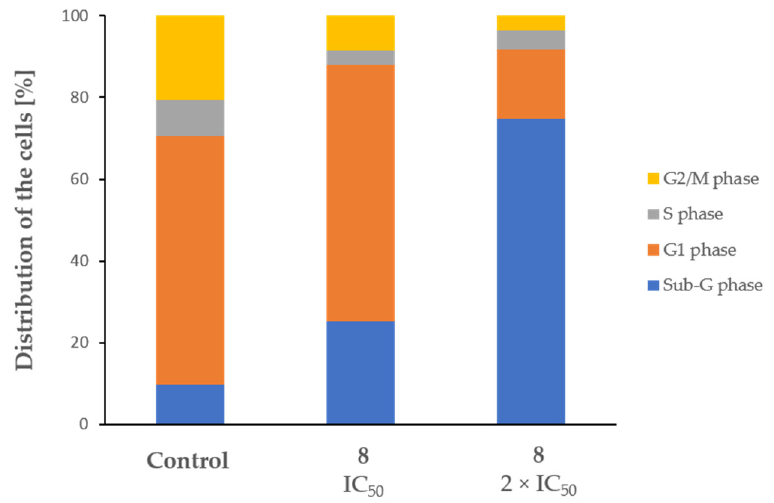
Figure 5. The impact of compound 8 on the distribution of PC3 cells in the cell cycle phases. Compound 8 was tested using IC 50 , 2 × IC 50 concentrations for 48 h (DAPI assay).